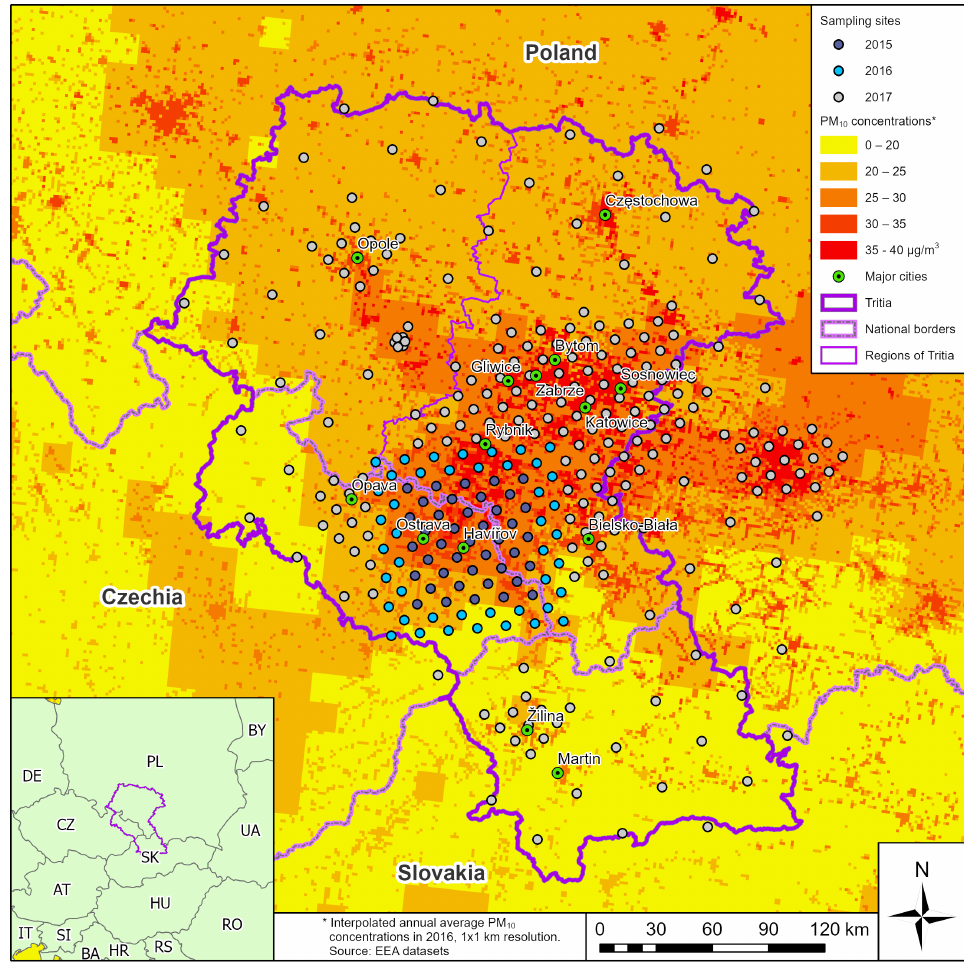
Figure 3. Sampling sites of the AIR TRITIA